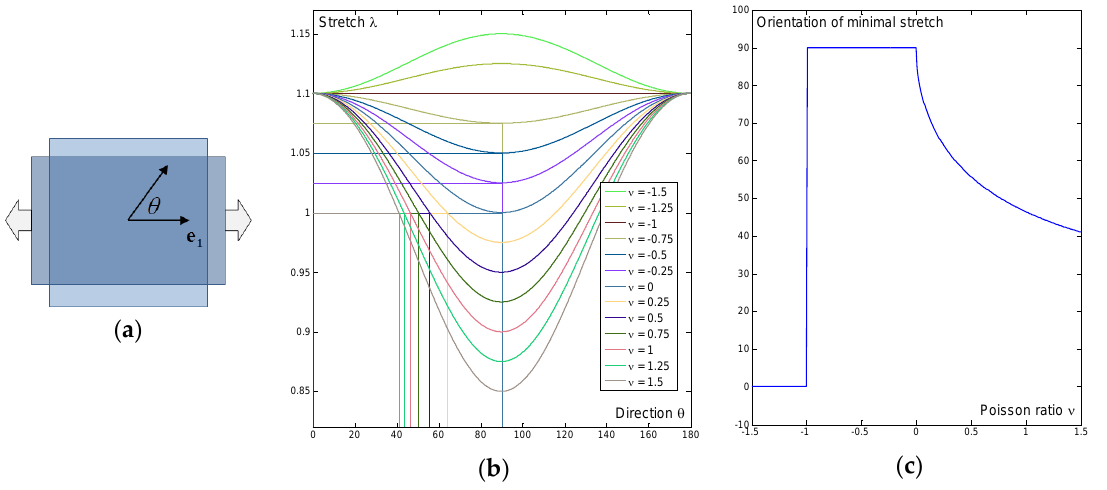
Figure 1. Illustration of the minimal stretch calculation in the case of two-dimensional uniaxial stretch. ( a ) Description of the orientation angle on a membrane subject to uniaxial tension; ( b ) Stretch as a function of the orientation with respect to the stretching direction for different values of Poisson’s ratio; ( c ) Orientation of the minimal stretch or unitary stretch as a function of Poisson’s ratio. Interestingly, a discontinuity is observed for auxetic material with a Poisson’s ratio of −1.